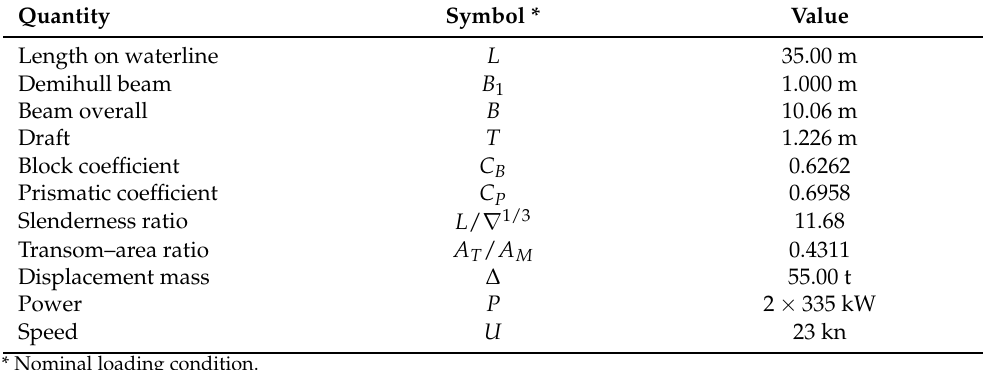
Table 1. Particulars of the Sydney RiverCat.